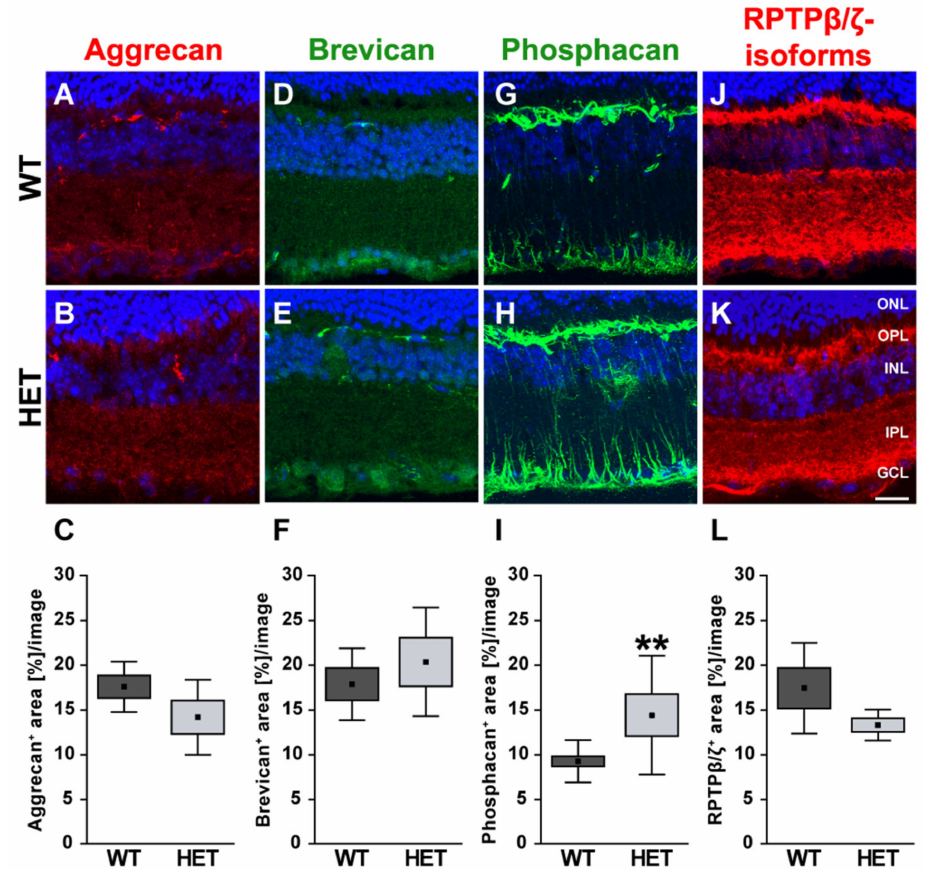
Figure 7. Enhanced phosphacan immunoreactivity in the glaucomatous retina of HET mice. Most representative immunohistochemical ECM stainings are shown. Stainings revealed a prominent signal for aggrecan (red; ( A , B )), brevican (green; ( D , E )) and all three RPTP β / ζ isoforms (red; ( J , K )) in the plexiform layers and the GCL. The phosphacan signal was restricted to Müller glia fibers (green; ( G , H )). Quantification showed a significant upregulation of phosphacan in the HET retina ( I ). No changes were noted for aggrecan, brevican and all RPTP β / ζ isoforms ( C , F , L ). TO-PRO-3 (blue) was used to detect the cell nuclei. Groups were analyzed by Student‘s t -test. Data are shown as mean ± SEM ± SD. ** p < 0.01. n = 5/group. Scale bar = 20 µ m. Abbreviations: ONL—outer nuclear layer, OPL—outer plexiform layer, INL—inner nuclear layer, IPL—inner plexiform layer, GCL—ganglion cell